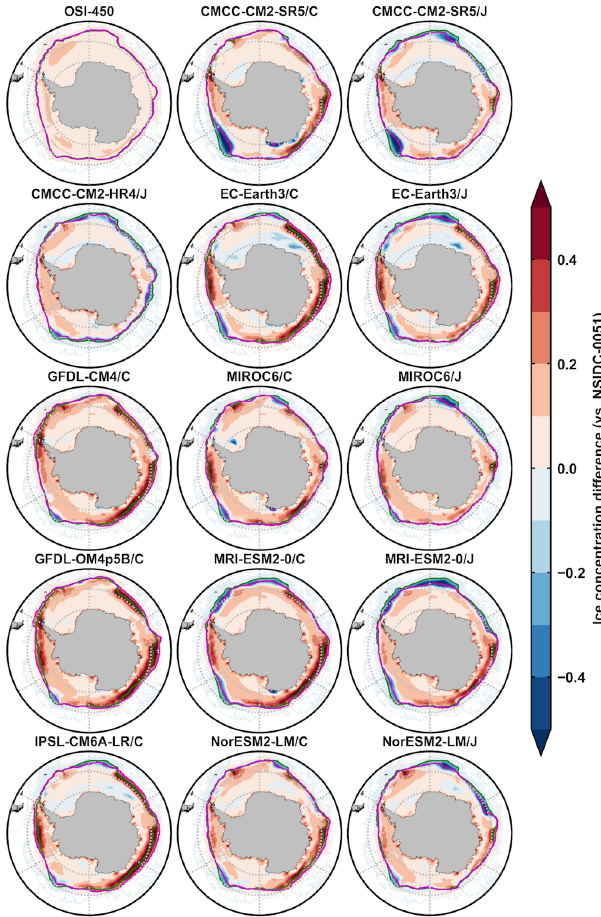
Figure A4. The 1980–2007 September mean Antarctic ice con- centration differences between OSI-450/model outputs and the NSIDC-0051 data (colors), and contours of 15% concentration of the NSIDC-0051 data (green lines) and OSI-450/model out- puts (magenta lines). The second and third columns are from the five OMIP1 and OMIP2 model outputs of CMCC-CM2-SR5, EC- Earth3, MIROC6, MRI-ESM2-0, and NorESM2-LM,